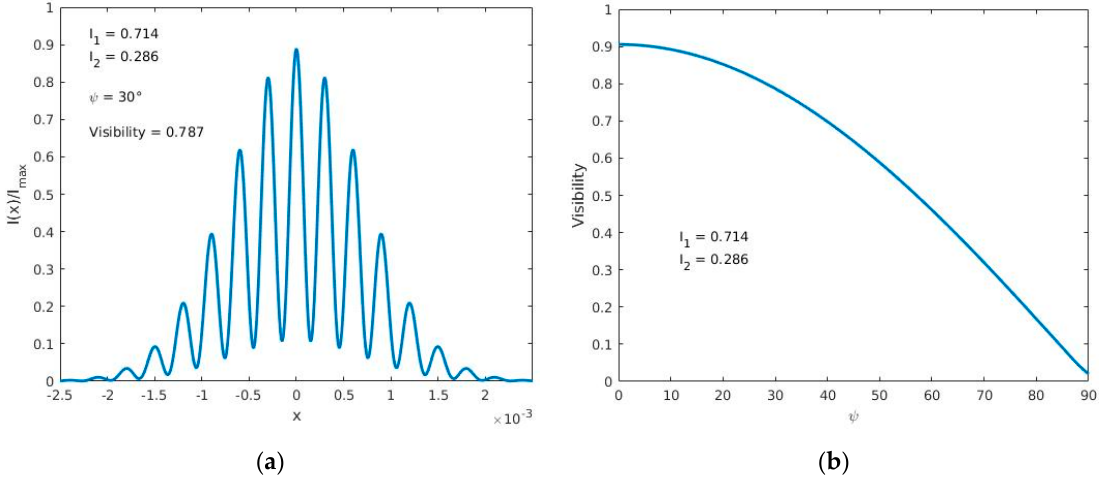
Figure 3. ( a ) Theoretical cross section Intensity pattern as a function of length of an interference pattern; ( b ) Theoretical behavior of interference pattern visibility as a function of the rotation angle (degrees) of the sample plane polarized light.